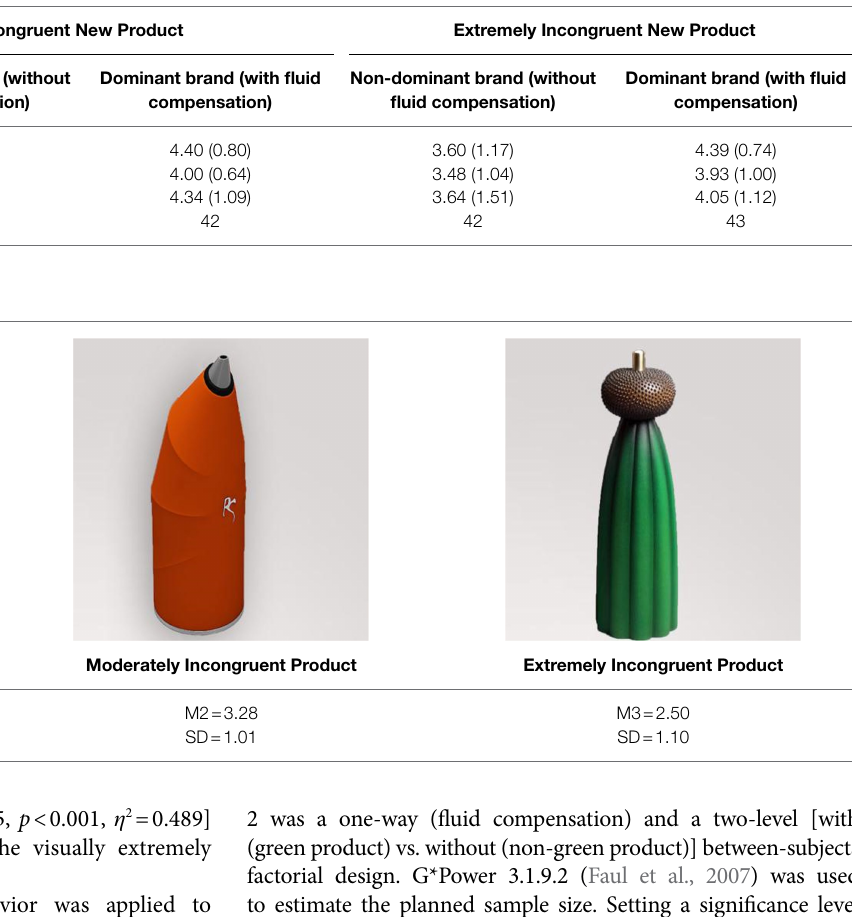
TABLE 3 | Differences between variables for different products.